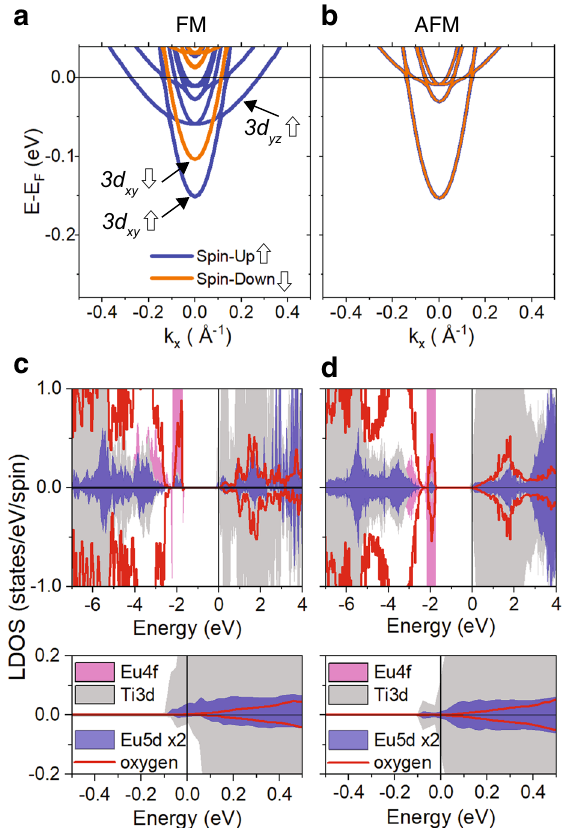
Fig. 6 Spin-resolved band structure and LDOS in the FM and AFM state from the DFT + U calculations. Spin-resolved band structure calculations of the Ti-3d bands around the Γ -point in a small energy range in the ( a ) FM (left panel) and ( b ) AFM (right panel) solutions of the model. Note that in the FM solution, the spin-up 3d yz band shift to lower energy and crosses the Fermi level, while the 3d xy spin- down bands shifts up, giving rise to an overall spin-polarization of the q2DEG. Element and spin-resolved density of states from the DFT + U calculations for EuTiO 3 layers (average) with ( c ) FM and ( d ) AFM coupling (same vertical scales in a , b ). In the FM solution we do observe a substantial spin-polarization at − 2 eV of both Eu-4f (magenta) and Eu-5d (blue) states, and an overlap between Ti- 3d states (gray) and Eu-5d states near and above the Fermi level, absent in the AFM 2 uc of ETO and 5 uc of LAO on both sides of a symmetric TiO 2 - terminated 6.5 uc STO slab (Fig. 5a). Along the c-axis the LAO surface is separated by a vacuum region of 20 Å from its periodic images. Calculations with larger STO stacks of 10.5 uc and 14.5 uc are shown in Supplementary Fig. 7 and give qualitatively similar results. On-site effective Hubbard parameter U = 4 eV, 7.5 eV and 8 eV were applied on the Ti-3d, Eu-4f and La-4f states, respectively. Similar to fi ndings for the ETO (001) surface state 28 , the choice of U